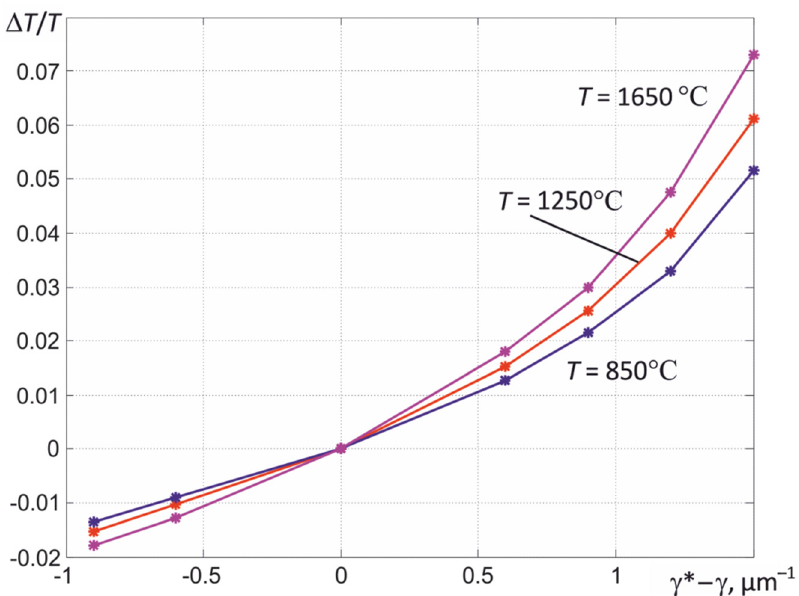
Figure 12. The results of evaluating the relative error in determining the temperature when the used value γ * deviates from its true value γ .